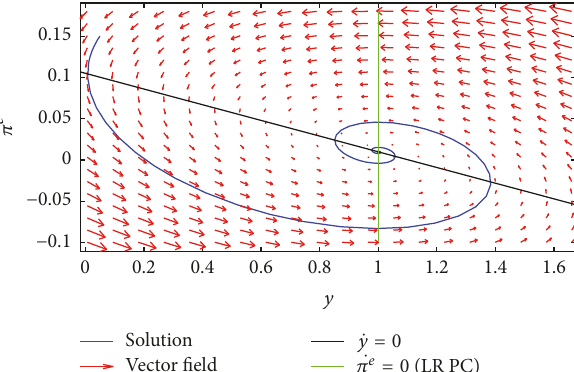
Figure 1: Simulation (1) . (a) Solution for 𝑦(𝑡) . (b) 𝜋(𝑡) and 𝜋 𝑒 (𝑡) .